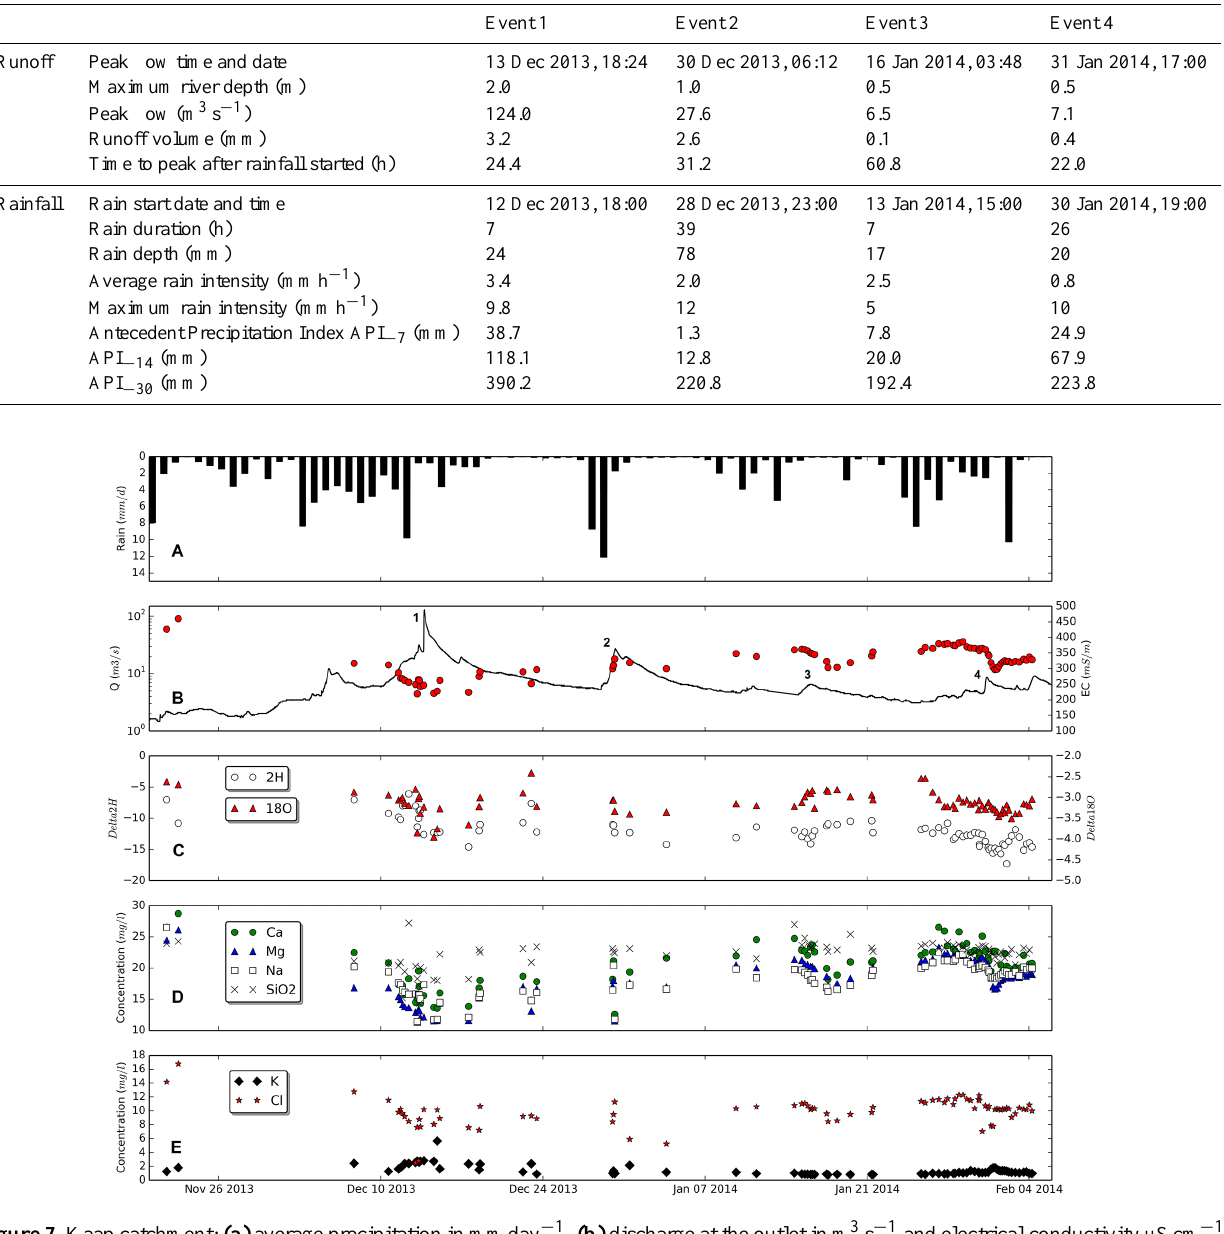
Figure 7. Kaap catchment: (a) average precipitation in mmday − 1 , (b) discharge at the outlet in m 3 s − 1 and electrical conductivity µScm − 1 , (c) delta deuterium and delta oxygen-18 in ‰ VSMOW, (d) calcium, magnesium, sodium and silica concentrations at the outlet in mgL − 1 , and (e) chloride and potassium concentrations at the outlet in mgL − 1